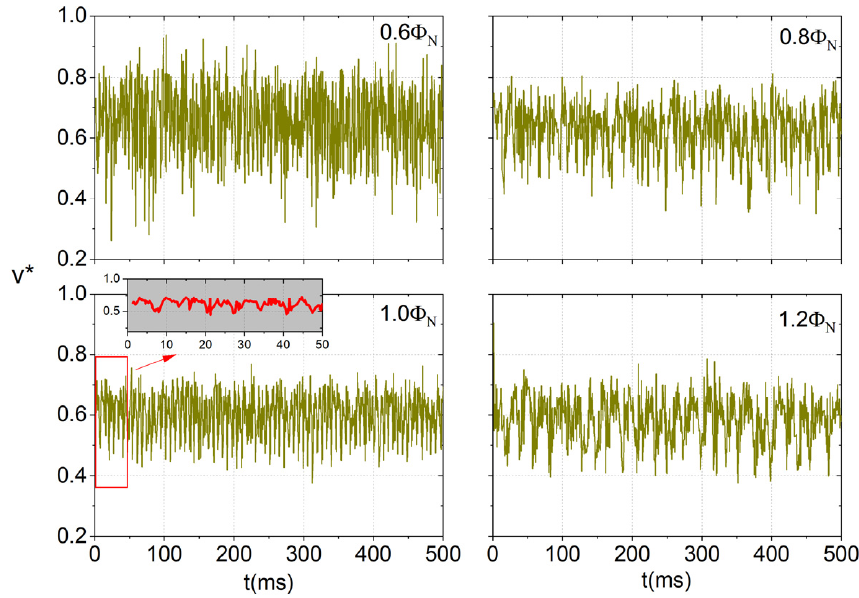
Figure 6. Velocity signals at point I4 at four typical working conditions.